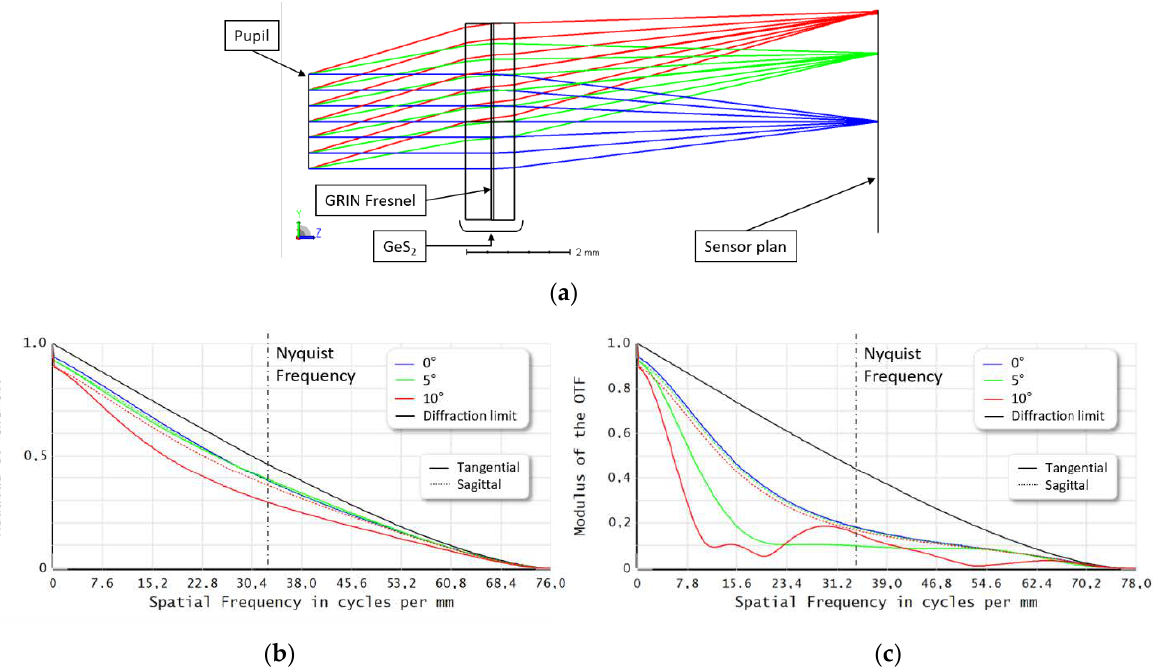
Figure 3. ( a ) Zemax 2D layout of a GRIN Fresnel lens with (from left to right) the pupil, the GeS 2 sample with a 100 µm thick GRIN Fresnel lens in the center of the sample and the image surface. Below, two Modulation Transfer Functions (MTF) given for three different half-fields of view (0°, 5° and 10°). ( b ) The MTF is given for the central wavelength ( λ = 3.3 µm ). ( c ) The MTF is given for three different wavelengths of the spectral bandwidth: 3.2 µm, 3.3 µm and 3.4 µm.